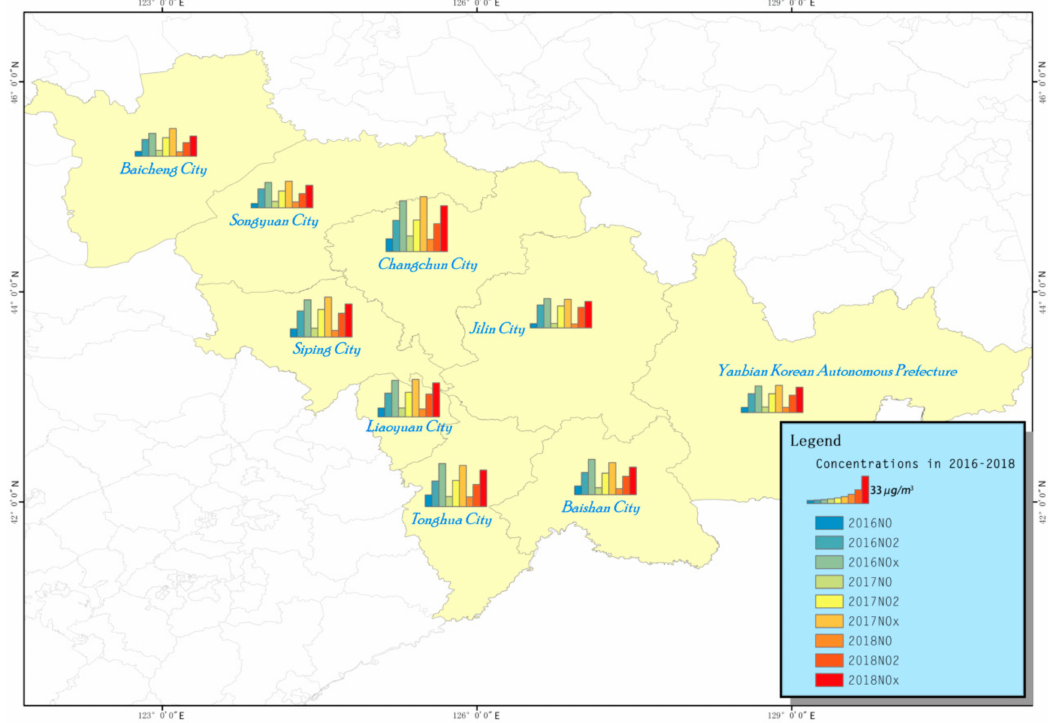
Figure 2. Spatial distribution of NO x , NO 2 , and NO in Jilin Province,